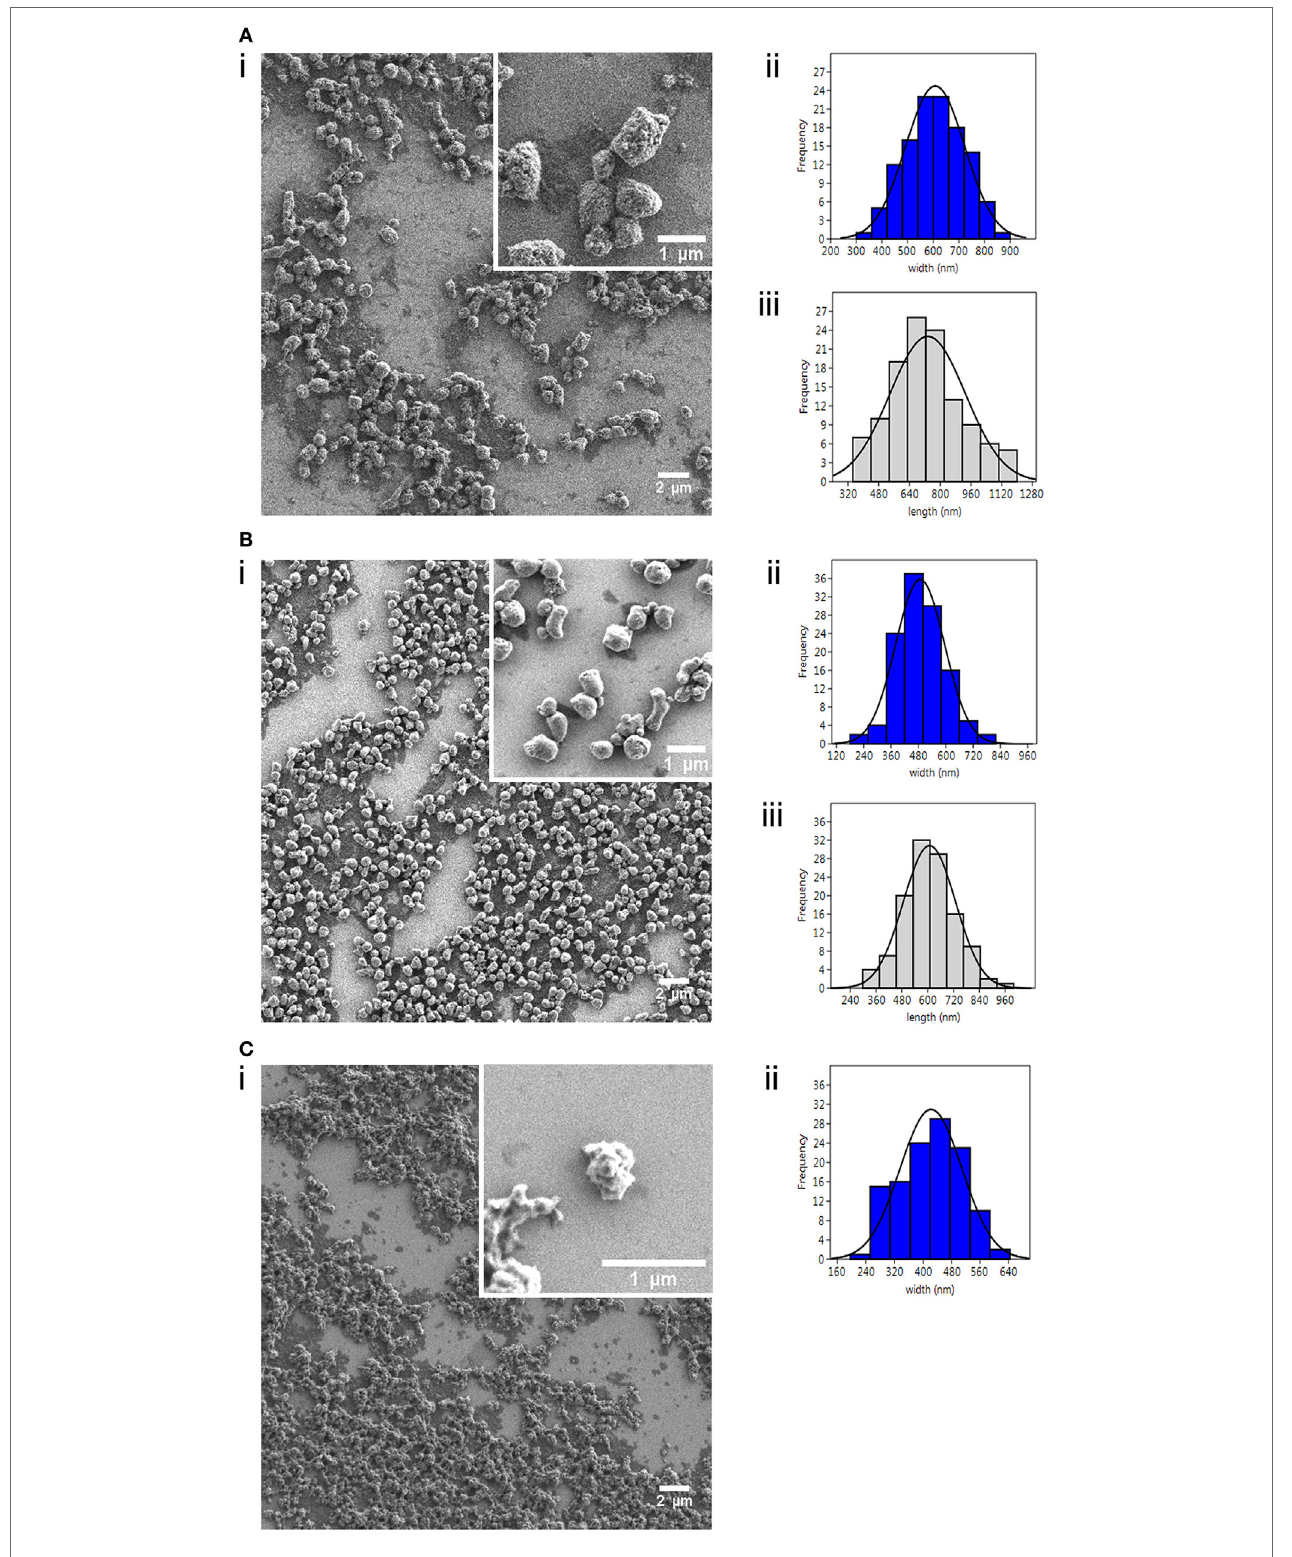
FigUre 1 | Characterization of nanostructured viral antigenic proteins. Field Emission Scanning Electron Microscopy images (i) of the three nanopellets (NPs): (a) IPNV-VP2 NP , (B) VHSV-G-frg16 NP , and (c) VNNV-C NP ; with corresponding size distribution histograms ( n = 120) for (ii) width (nm) and (iii) length (nm). Note there is no histogram (iii) for (c) , as these NPs were amorphic in